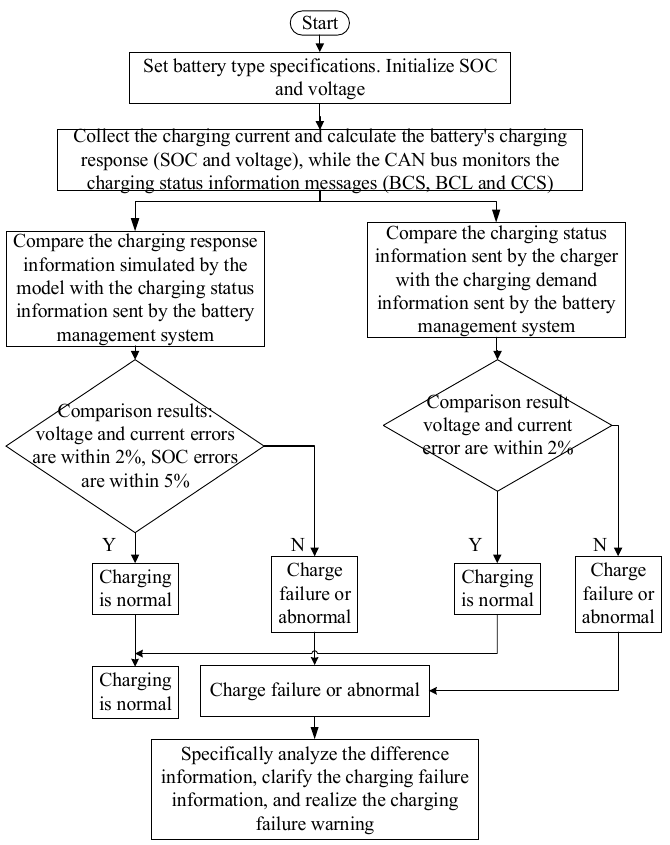
Figure 10. Flow chart of fault monitoring implementation plan.